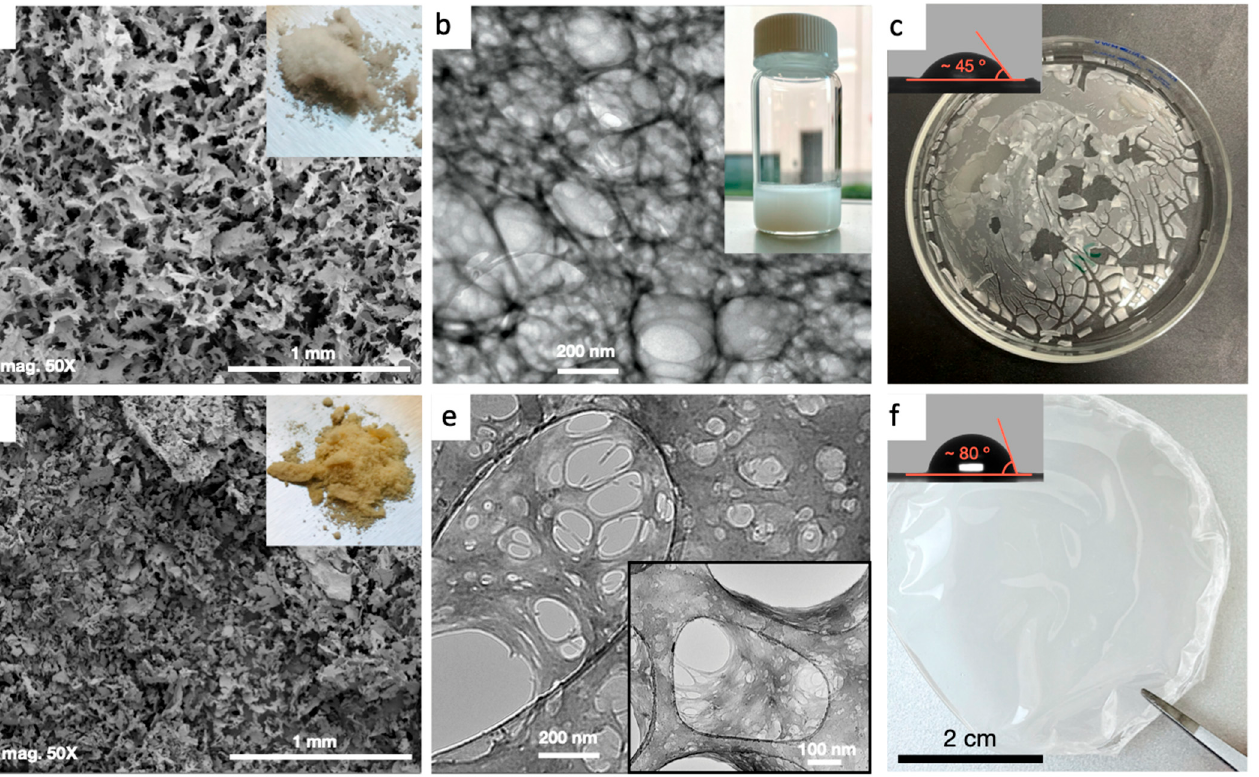
Figure 3. ( a ) SEM image of freeze-dried NC material with inset of a digital image of the powder, ( b ) TEM image of the NC suspension with inset of a digital image of the suspension, ( c ) digital image of the NC film after suspension is cast and dried with inset image of the water contact angle of the dried film, ( d ) SEM image of freeze-dried CRC material crosslinked with 25% GA for 24 hr (CRC 25% 24 hr) with inset of a digital image of the powder, ( e ) TEM image of the CRC-25%-24 hr suspension cured at 25 °C for 1 hr, with the inset of TEM for the CRC-25%-24 hr suspension cured at 40 °C for 1 hr, and ( f ) digital image of the CRC-25%-24 hr film after suspension is cast and dried with inset image of the water contact angle of the dried film.